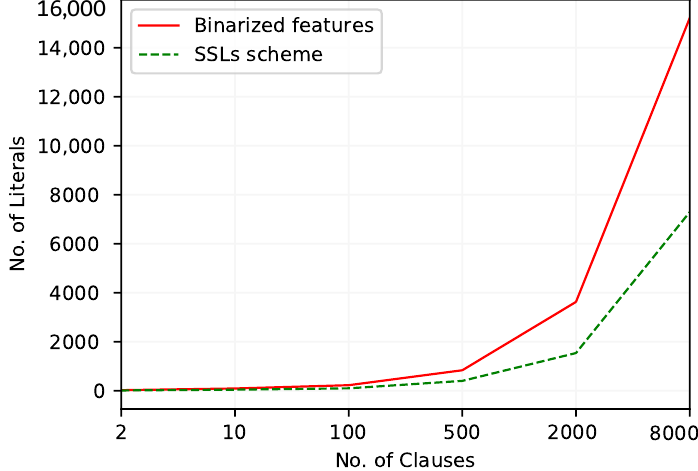
Figure 3. The number of literals included in TM clauses to work with Bankruptcy